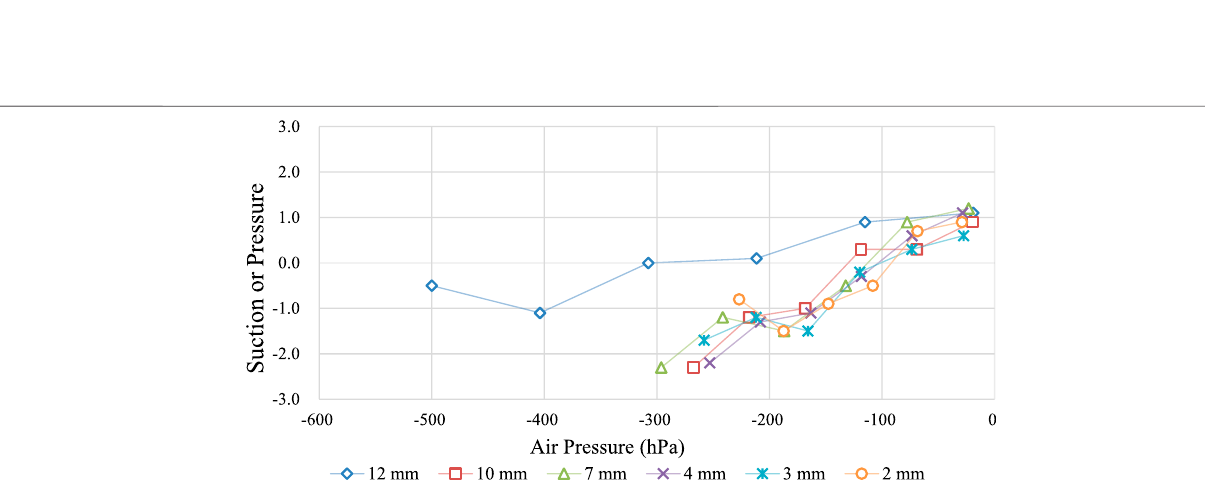
FIGURE 7 | Perceptions of suction and pressure at different suction diameters and pressures. The score is − 3 for suction and +3 for pressure perception.